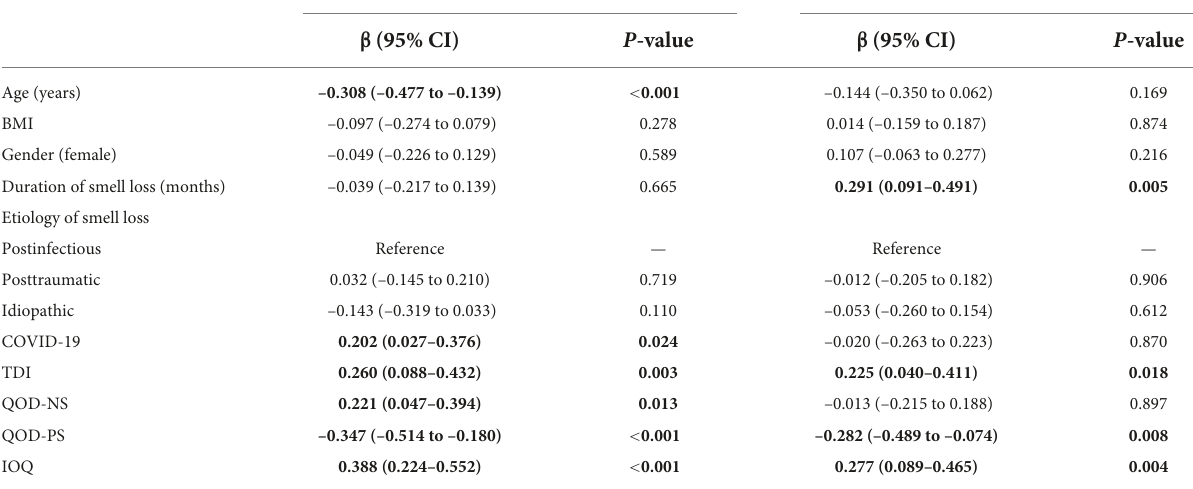
TABLE 3 Associations with external eating.